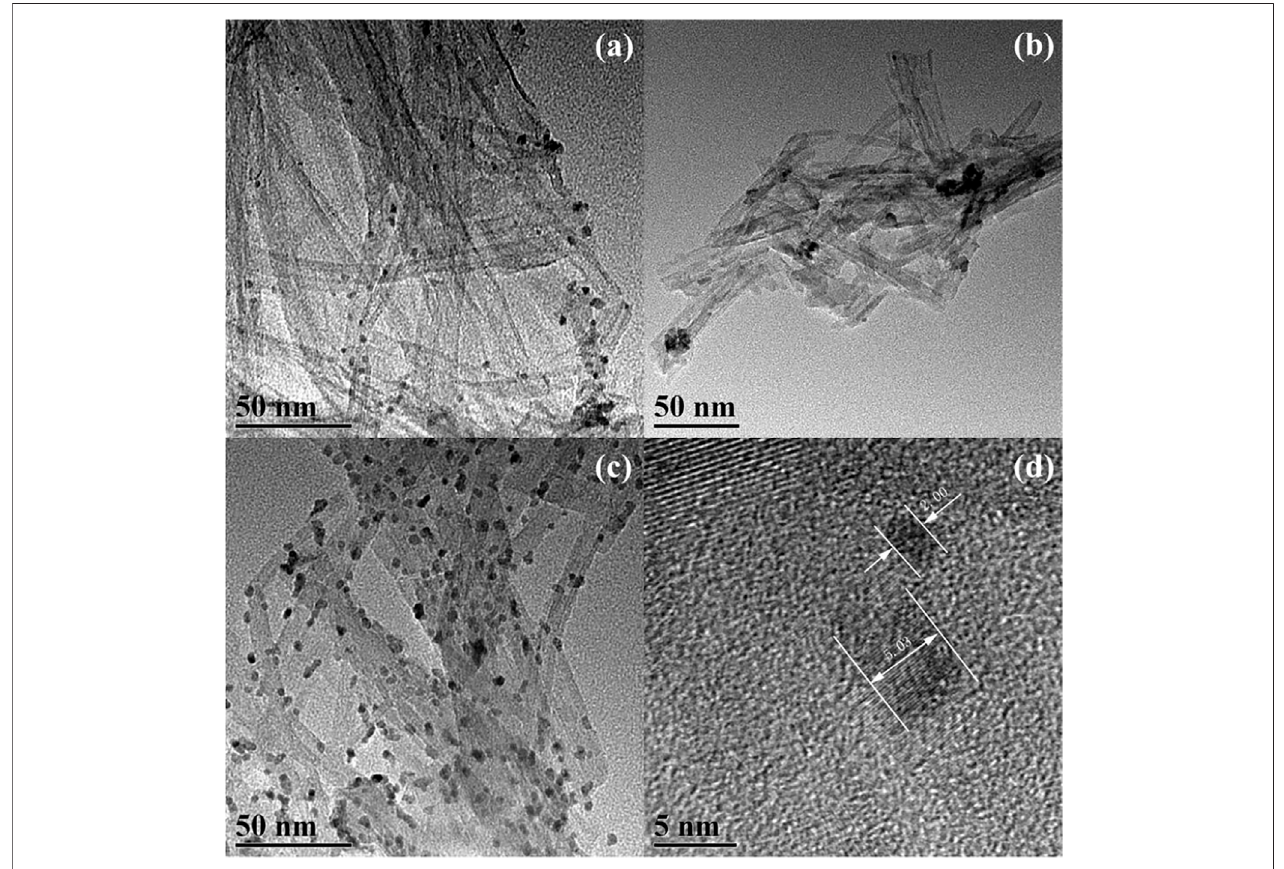
FIGURE 3 | TEM images of TNT-300-Pt (A) , TNT-400-Pt (B), and TNT-500-Pt (C) , scale bar: 50 nm, Pt nanoparticle size (D) .